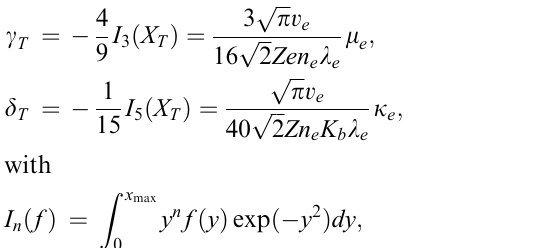
Table 1. The normalized transport coe(cid:129)cients as defined in Eqs. (4) to (7) calculated for di(cid:128)erent values of x the ones given by Spitzer and Ha¨ rm ( x